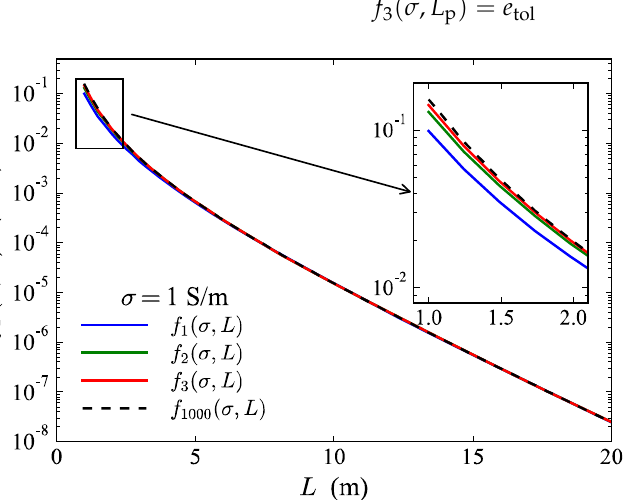
Figure 3. P -th order approximation f P ( σ , L ) of the infinite series f ( σ , L ) for the four different P = 1, 2, 3 and 1000.